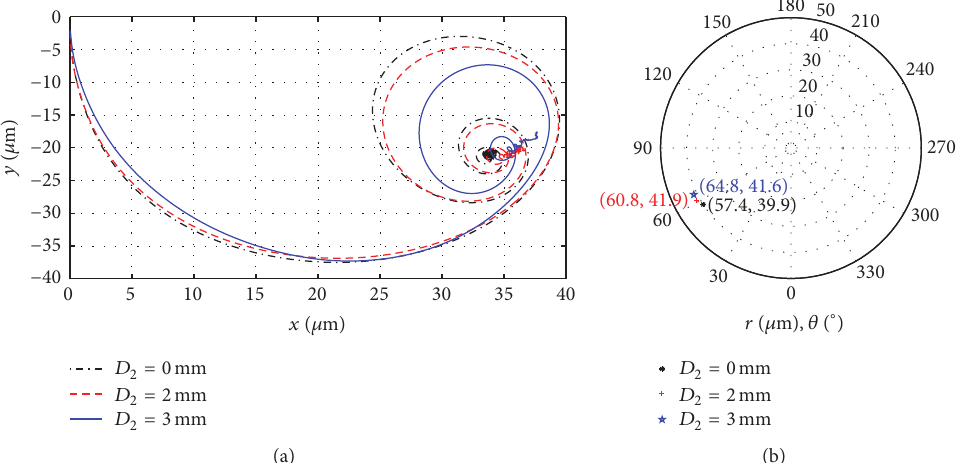
Figure 16: (a) Rotor trajectory and (b) polar coordinates of the HGGJB under different pressure relief hole diameter at the rotating speed of 10000 r/min.